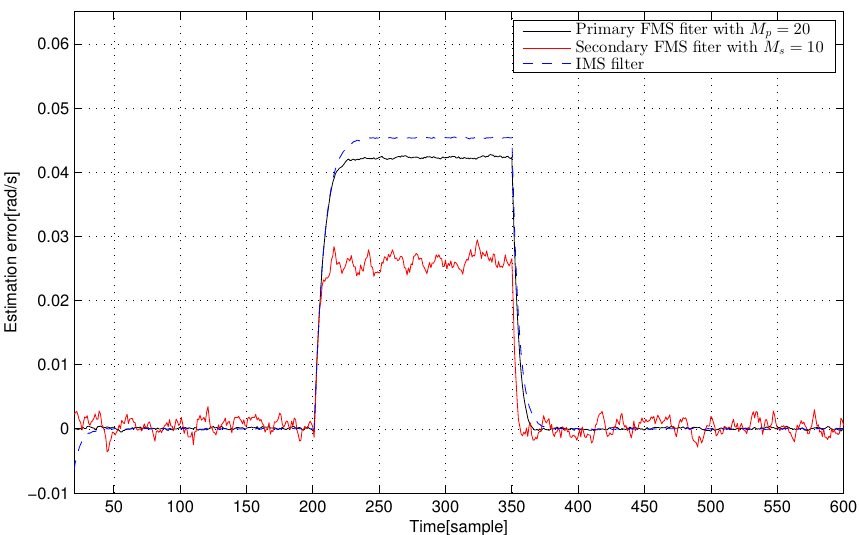
Figure 5. Estimation errors of the primary FMS, secondary FMS and IMS filters for the electric motor system.